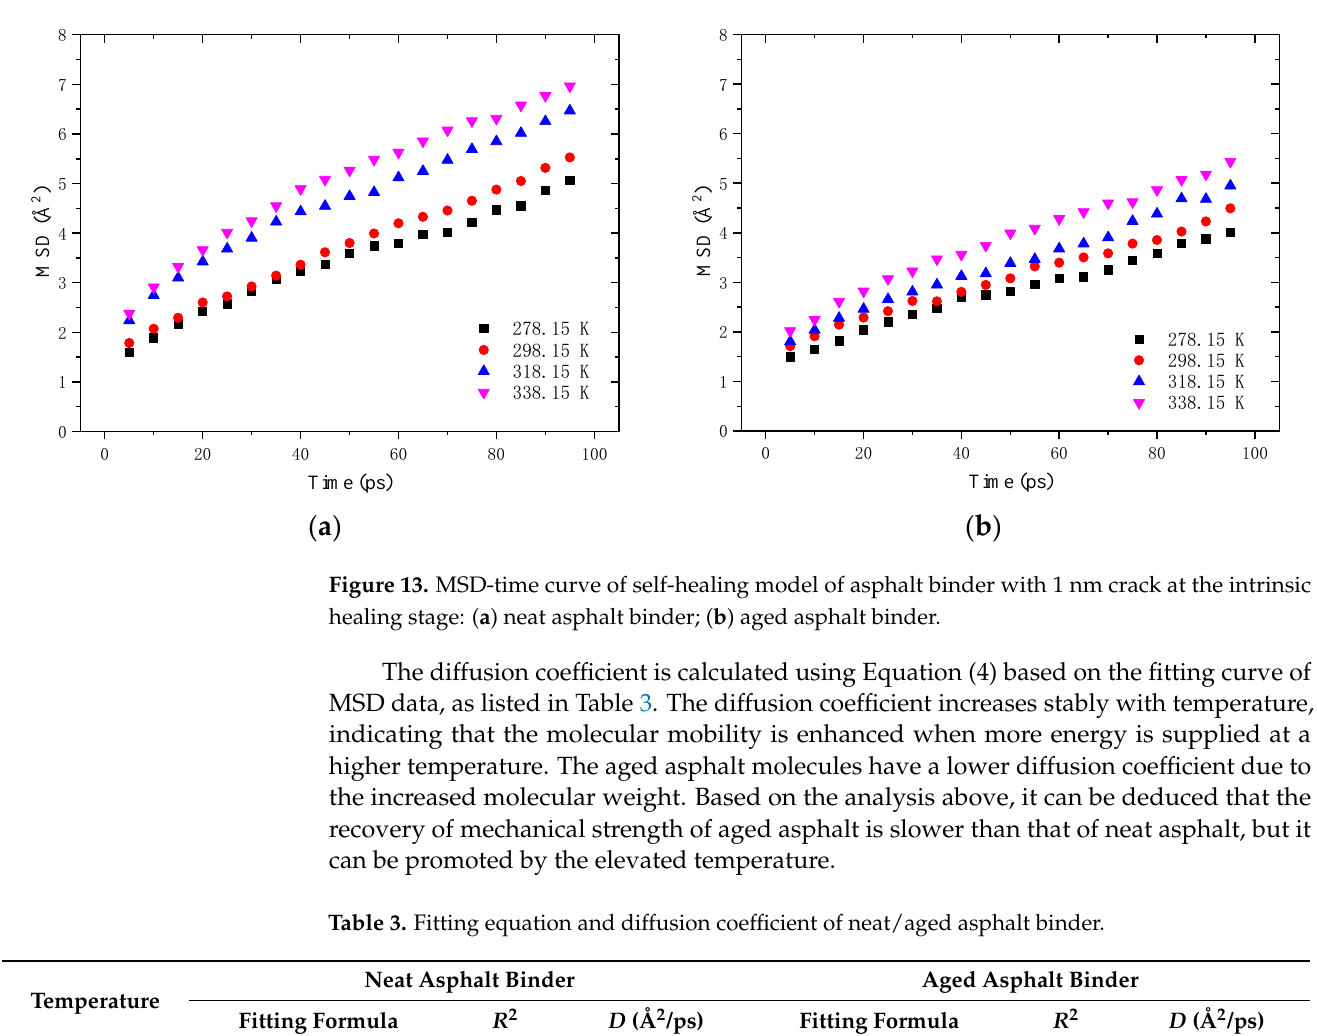
( b ) Figure 12. Self-healing efficiency of asphalt binder with 1 nm crack at different temperatures: ( a ) neat asphalt binder; ( b ) aged asphalt binder.